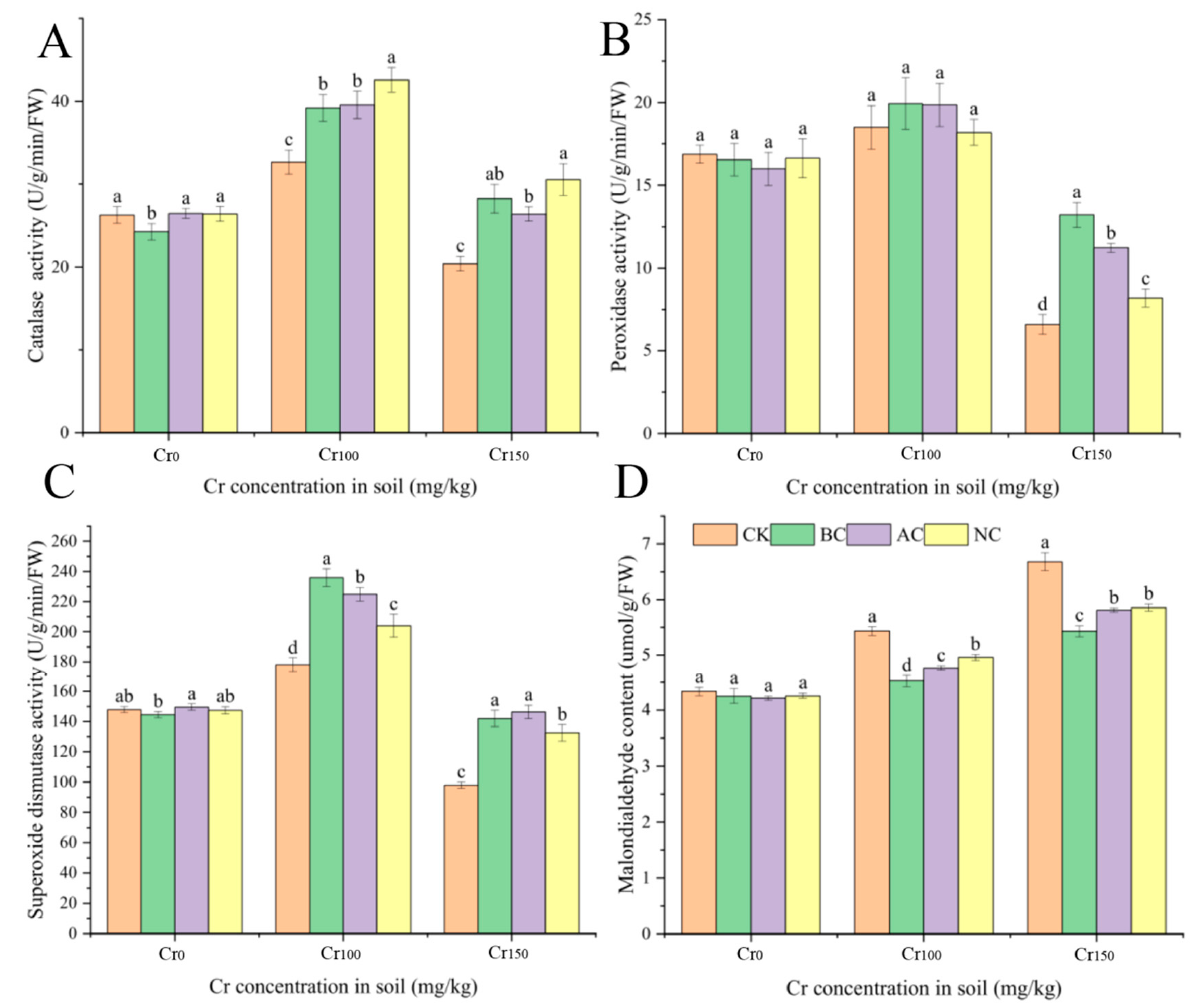
Figure 2. The effect of BC, AC, and NC application on the antioxidant activity of peach leaves under Cr stress. ( A ). The activity of catalase. ( B ). The activity of peroxidase. ( C ). The activity of superoxide dismutase. ( D ). The content of malondialdehyde. Data represent the means of three replicates ± SEs, and different letters indicate significant differences ( p <